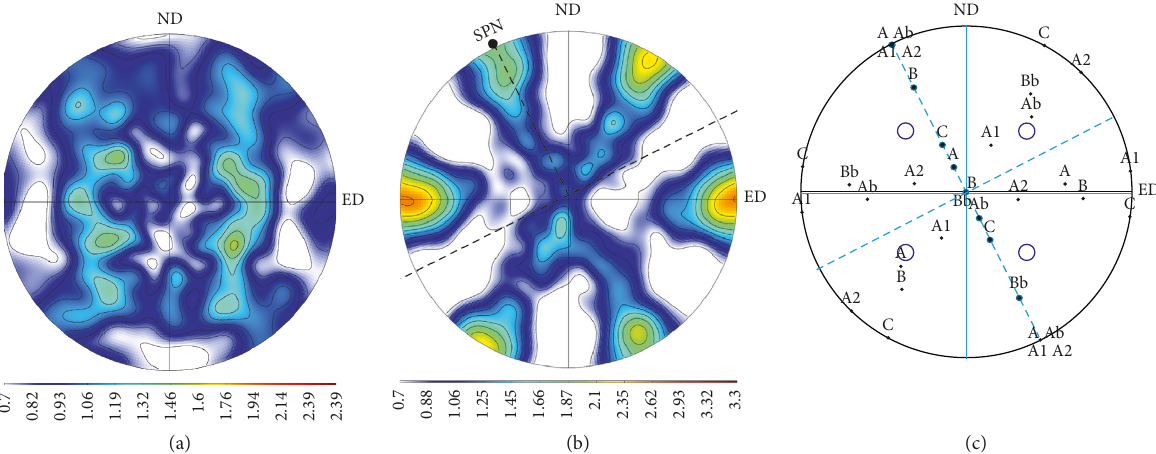
Figure 3: {111} pole figures of the initial texture (a) and the deformation texture after one NECAP pass (b). SPN is the shear plane normal. The key figure of the ideal orientations of shear textures of the NECAP process is presented in (c) for p / c